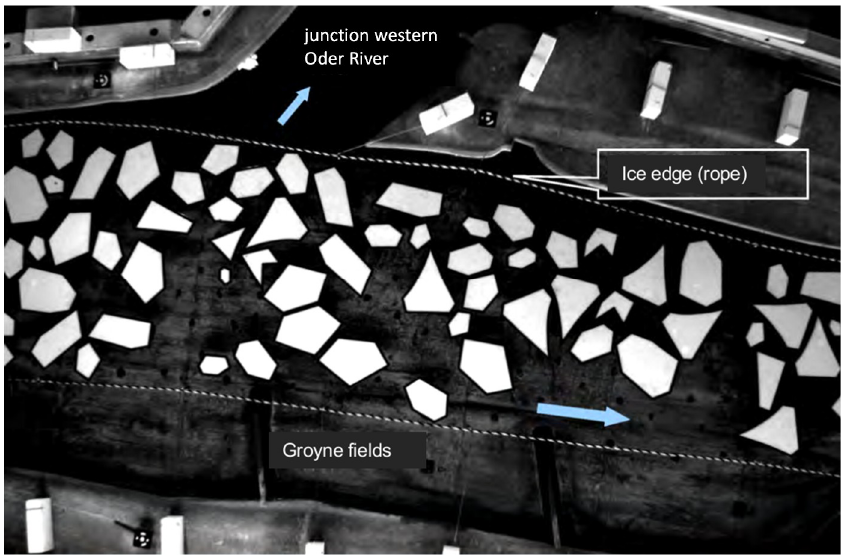
Figure 19. Setup of physical model of the Oder River near Widuchowa, which forks into the Western and Eastern channel branches of the river (adapted from [21]).